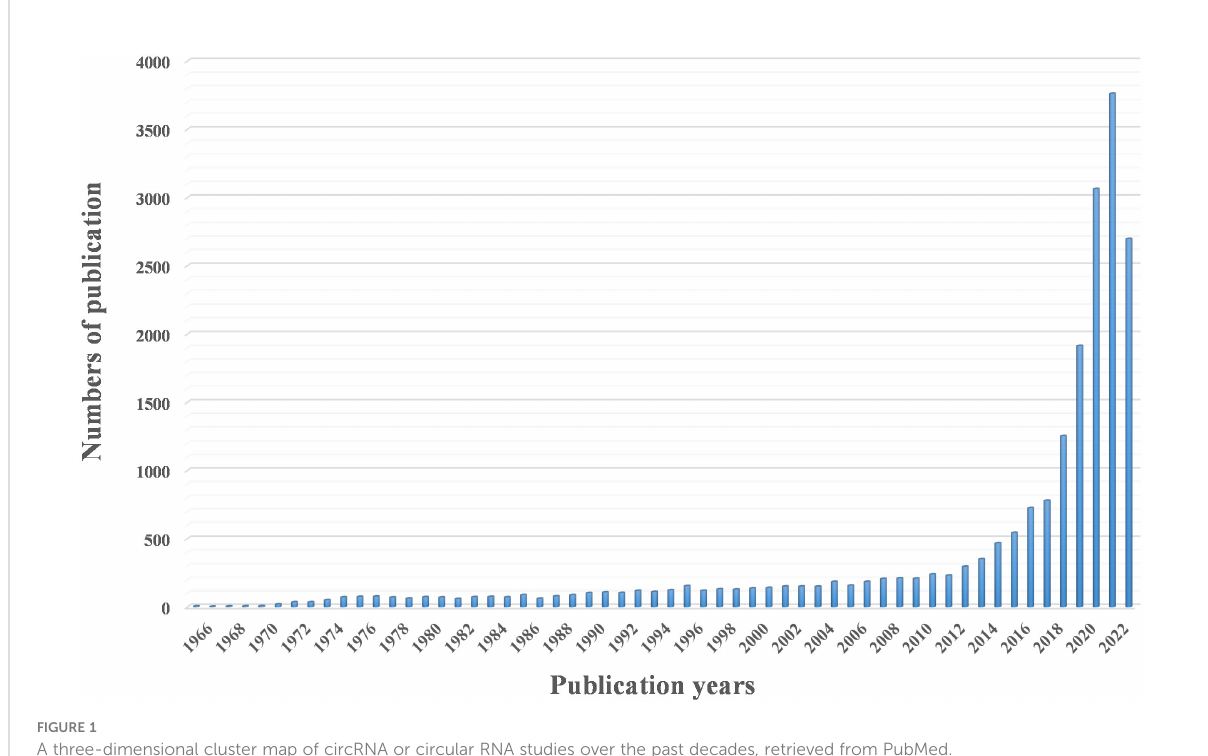
FIGURE 1 A three-dimensional cluster map of circRNA or circular RNA studies over the past decades, retrieved from